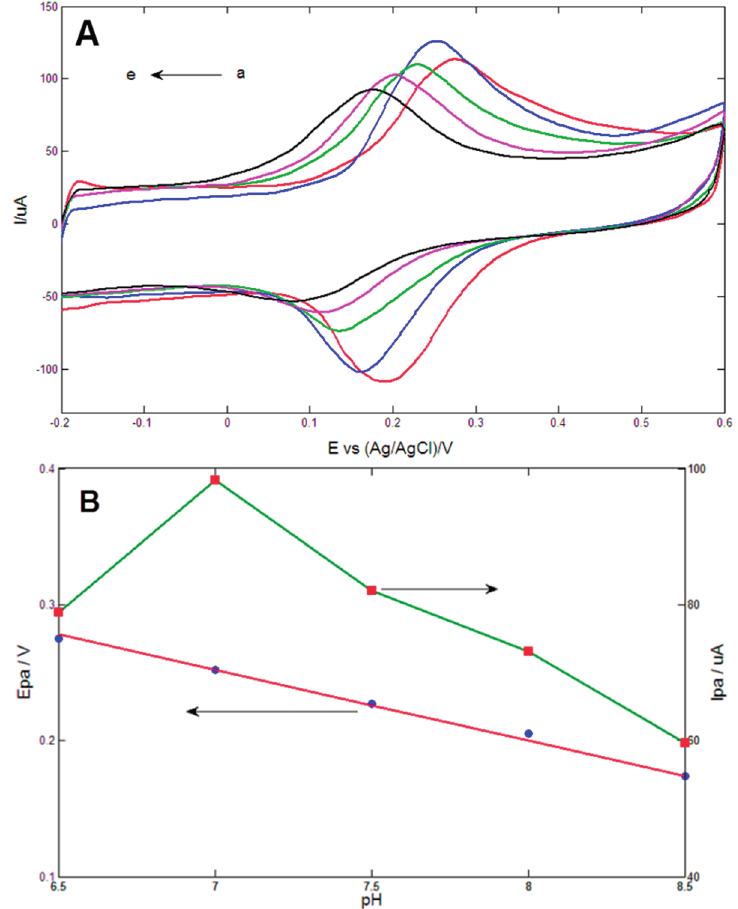
Figure 5. ( A ) Cyclic voltammetrys of Au1Pt1NPs-GR/GCE in 0.1 M PBS (pH values from a to e : 6.5, 7, 7.5, 8.0, 8.5) containing 0.2 mM DA at scan rate of 100 mV/s; ( B ) Plots of anodic peak potential ( E pa ) and anodic peak current ( I pa ) vs. pH